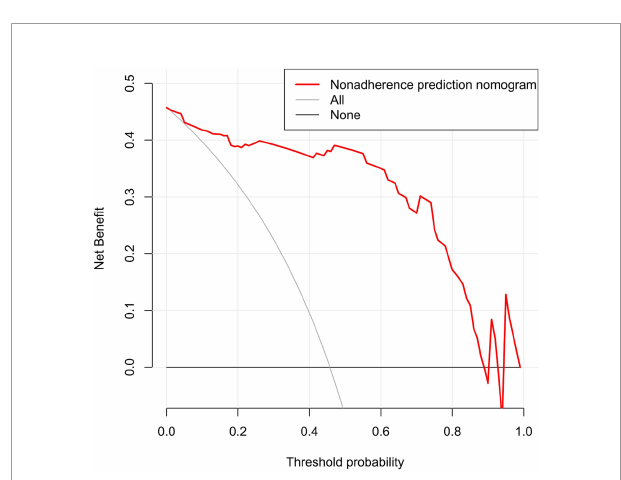
FIGURE 6 | Decision curve analysis (DCA) for radiomics nomogram in training cohort. The vertical axis displays standardized net bene fi t. The two horizontal axes show the correspondence between risk threshold and cost: bene fi t